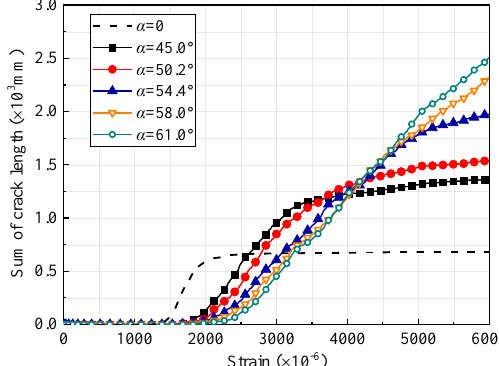
Figure 20. E ff ect of frictional angle on crack propagation under Figure 20. Effect of frictional angle on crack propagation under compression. Figure 20. Effect of frictional angle on crack propagation under compression. Figure 20. Effect of frictional angle on crack propagation under compression.